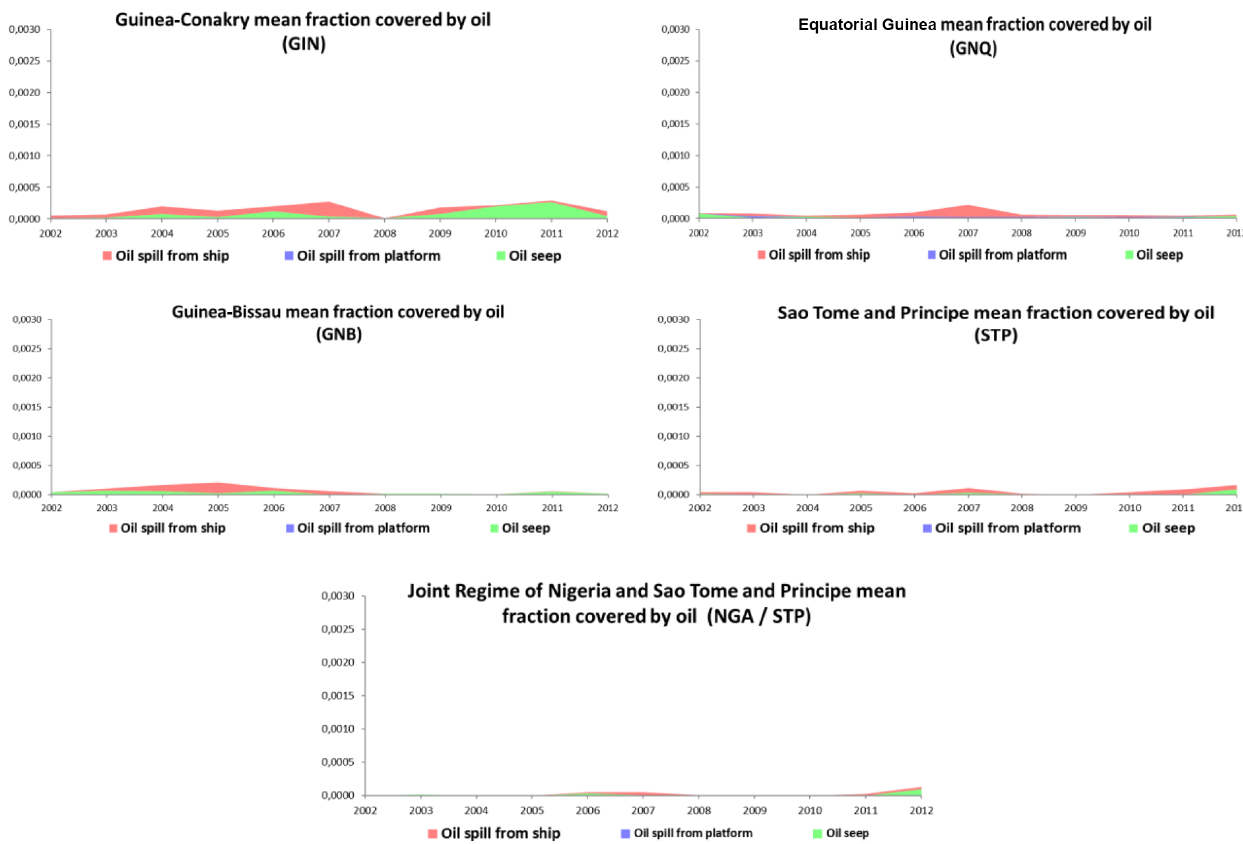
Figure 19. Mean fraction covered by oil by EEZ and year.